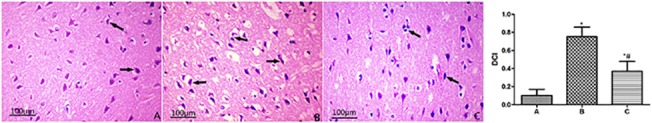
The morphology and structure of nerve cells in cortex in different group, HE×400.A. Control group; B. Model group; C. Treatment group; →. Denatured cells *P<0.05, compared with control group; #P<0.05, compared with model group